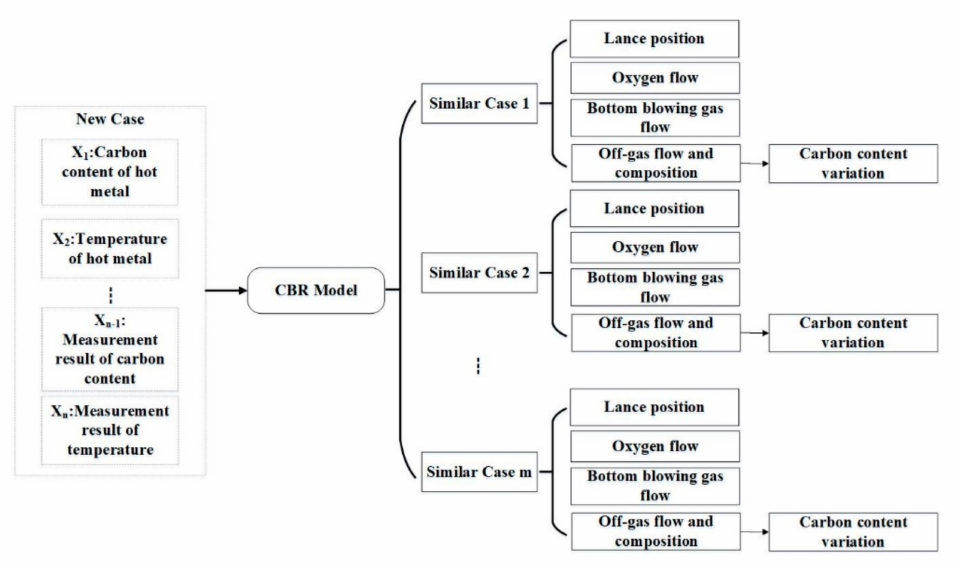
Figure 7. Process of similar case